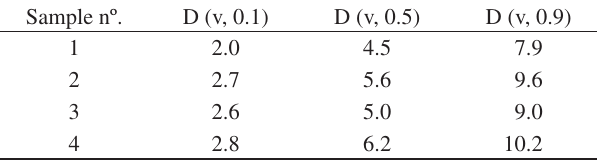
Table 1. Summery of the particle size ( µ m) distribution (diameter) of dif- ferent lime samples. Sample nº.